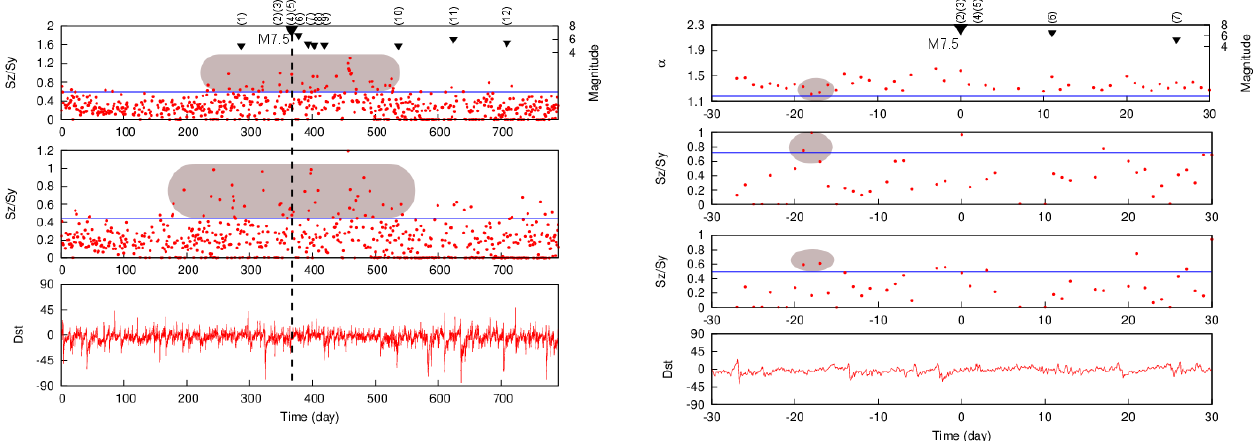
Fig. 9. The temporal variations of the spectral density ratio for ± 30 days around the largest EQ. The zero day is the day of the largest EQ. The first panel shows the DFA results ( α) for the verti- cal component. The second and the third panels indicate the spectral density ratio S z /S y without and with the use of the minimum energy at the frequency range of 0.01 ± 0.003Hz, respectively. The bottom panel indicates the Dst index. The black triangle indicates the occur- rence time of EQs listed in Table 1. The blue horizontal line in the first panel gives mean − 2 σ for a threshold of anomaly in α value, whereas in the middle two panels indicates mean + 2 σ for a thresh- old of anomaly in S z /S y . The grey-colored areas are corresponding to the anomalies in each